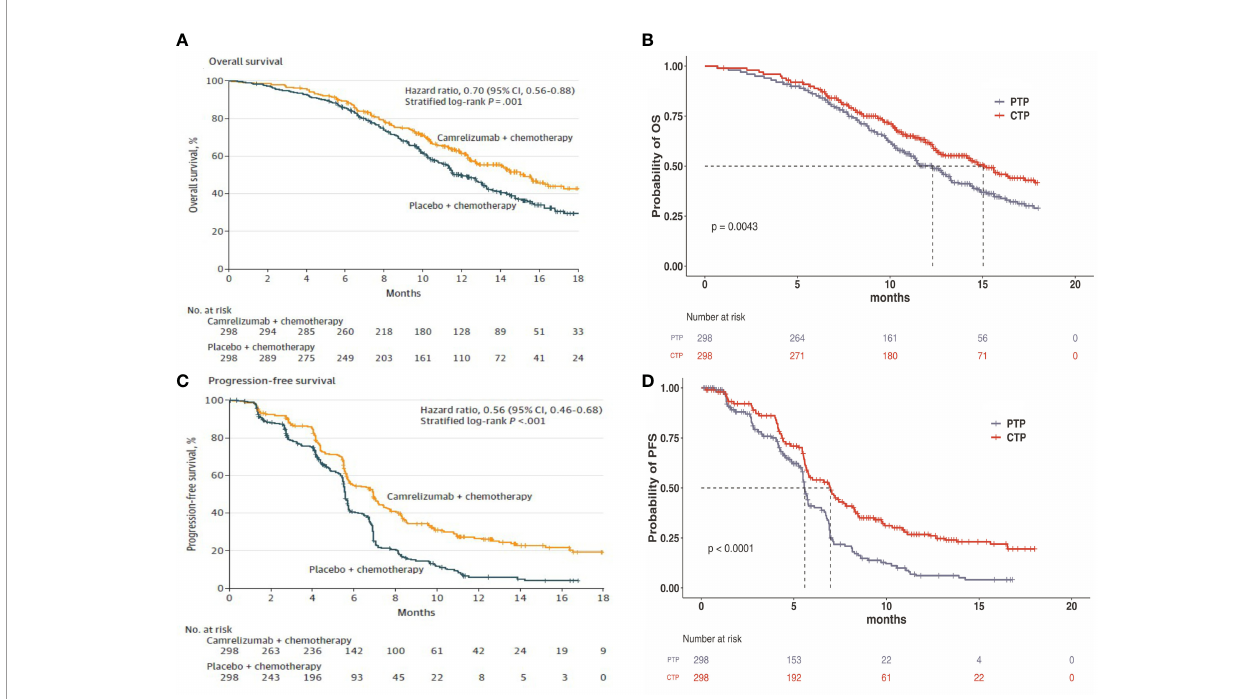
FIGURE 2 | (A) Kaplan – Meier curve of the overall survival from the ESCORT-1st trial. (B) Simulate overall survival curve for the CTP group and the PTP group. (C) Kaplan-Meier curve of progression-free survival from the ESCORT-1st trial. (D) Simulate progression-free survival curve for the CTP group and the PTP group. CTP, camrelizumab-chemotherapy; PTP, placebo-chemotherapy; OS, overall survival; PFS, progression-free survival.